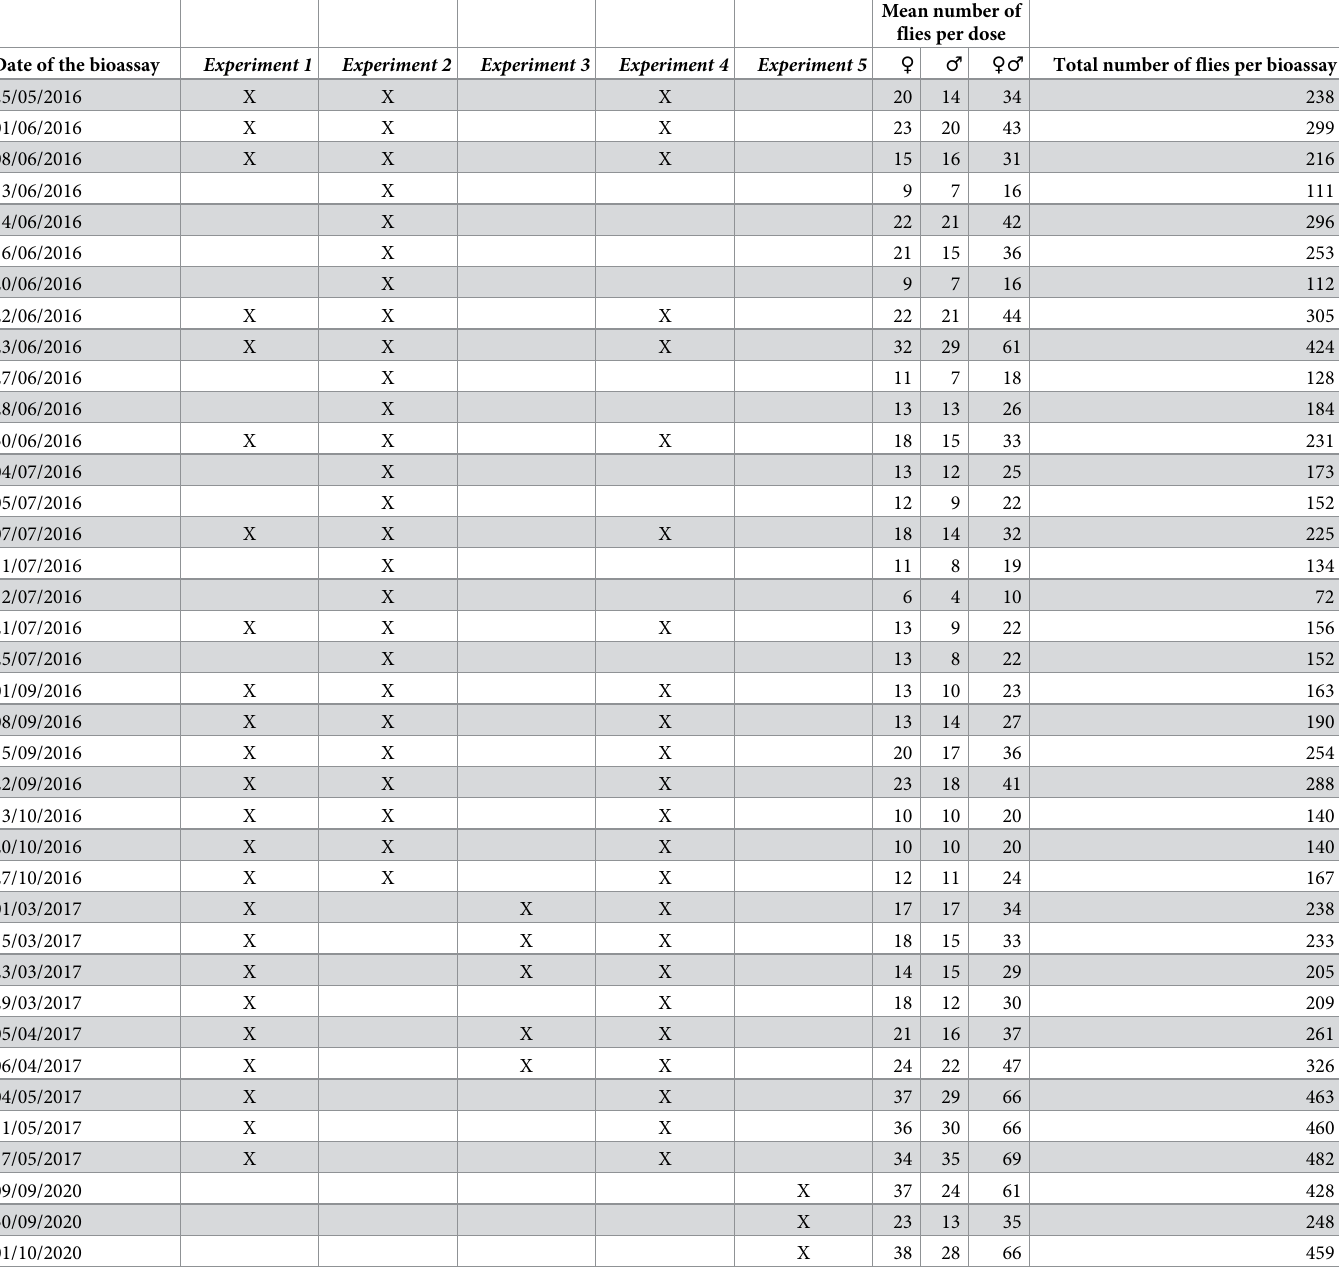
Table 2. Characteristics of the study’s bioassays. For each of the bioassays, the date of performance, the inclusion in the different experiments, the mean number of flies per dose (and per sex) and the total number of individuals used are